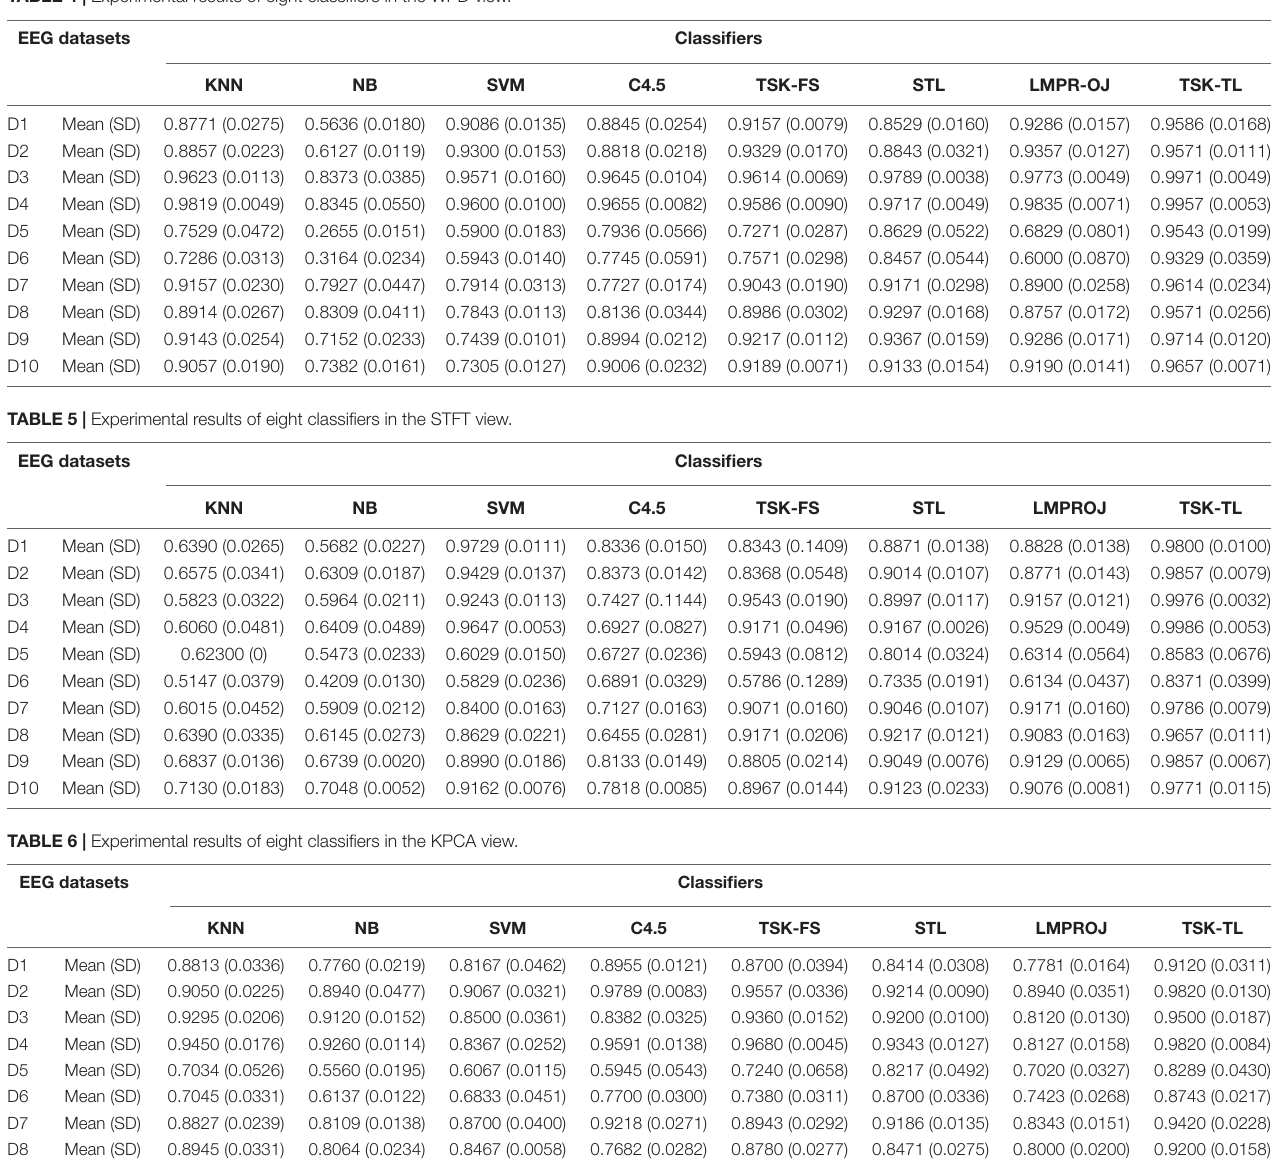
TABLE 4 | Experimental results of eight classifiers in the WPD view.